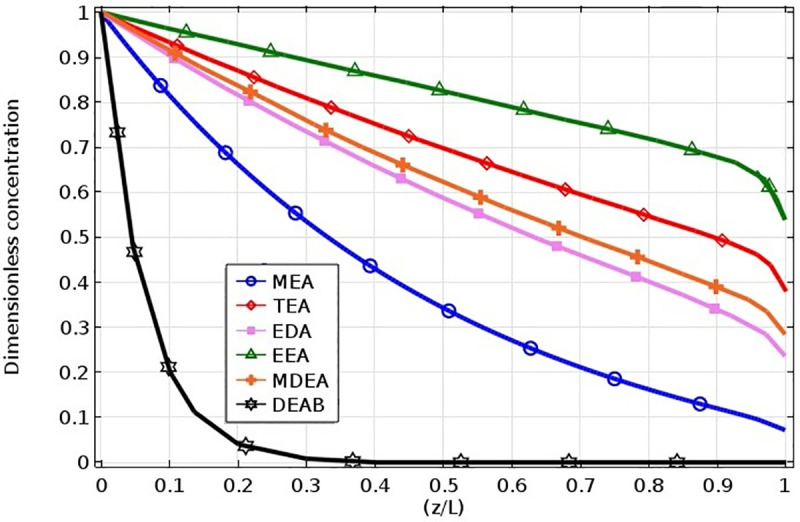
Axial dimensionless concentration profile of CO2 along the axial length of hydrophobic HFMC (membrane—tube interface) using MEA, TEA, EEA, EDA, MDEA and DEAB absorbents.